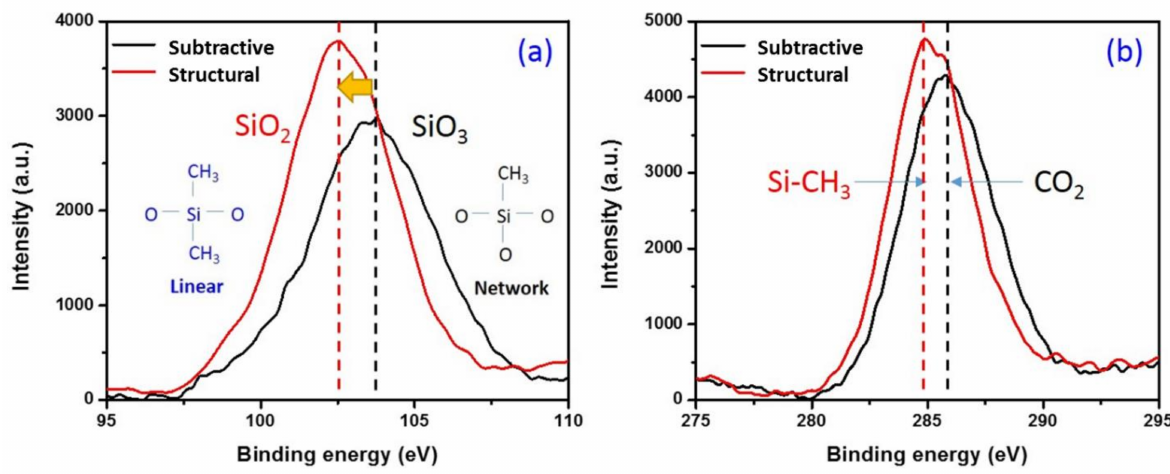
Figure 8. Peak shift of ( a ) Si 2p and ( b ) C